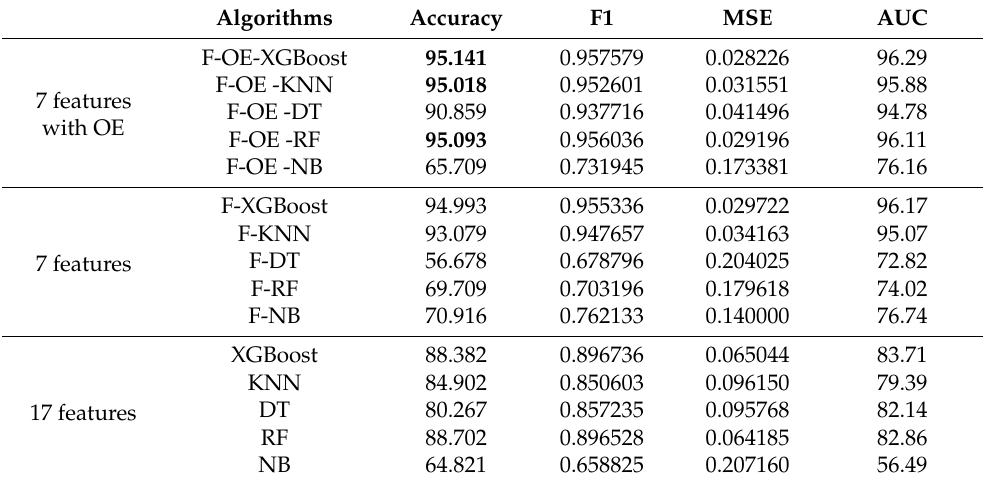
Table 5. Evaluation results of the compared algorithms on the experimental dataset